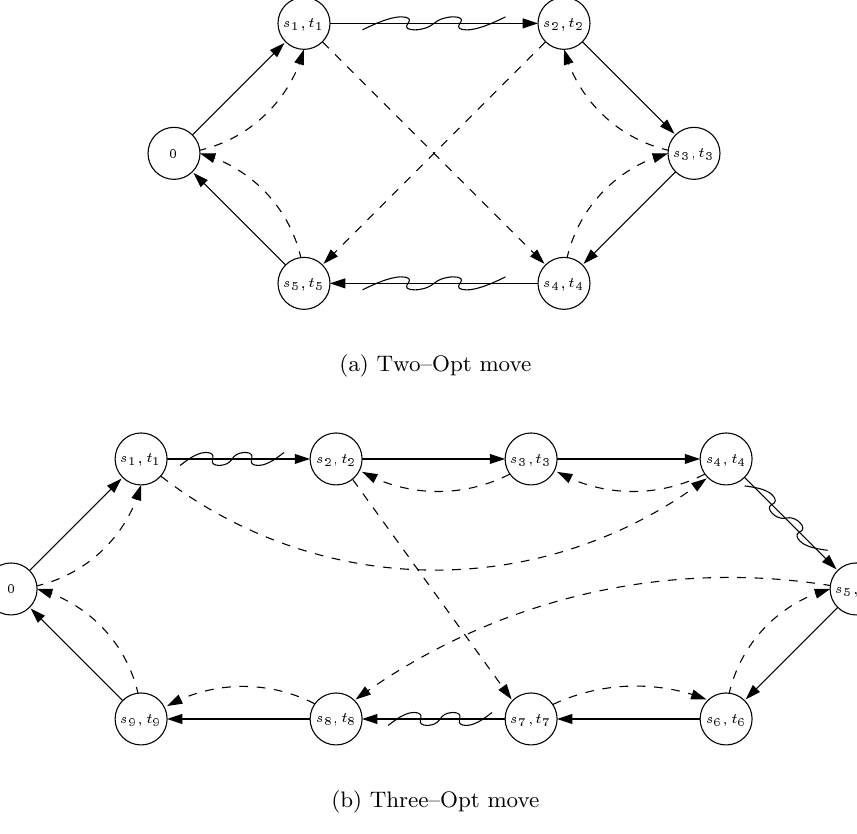
Figure 1: Operation of the Two–Opt and Three–Opt move types. Cancelled solid arcs are removed, and the route is reconnected as shown by the dashed